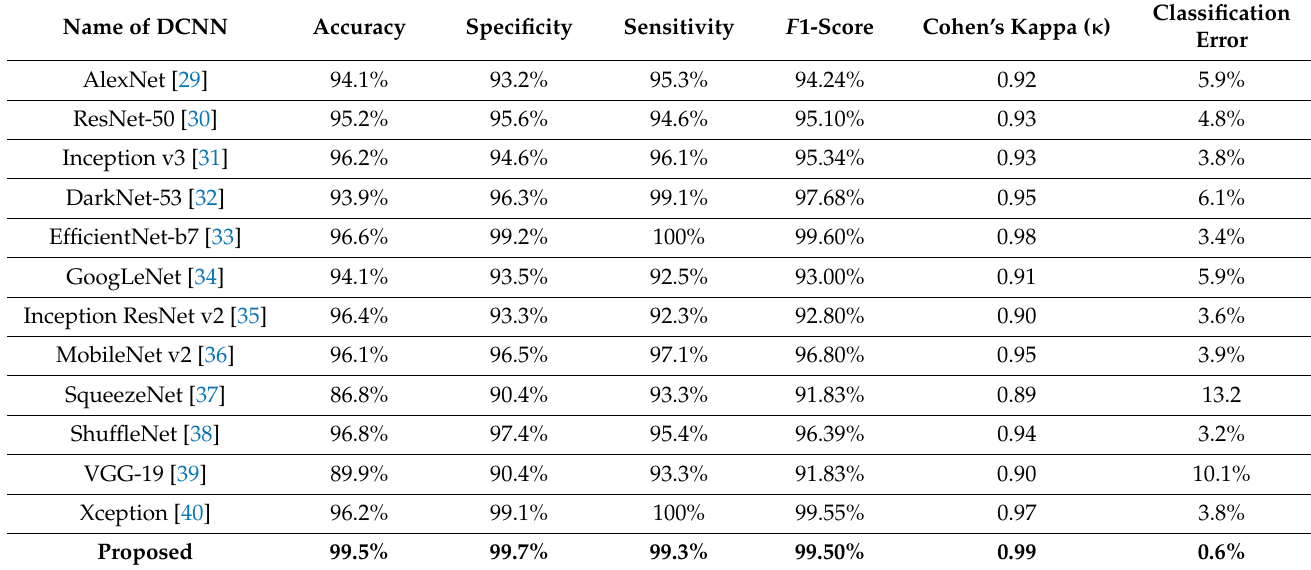
Table 3. Testing performance of different DCNNs for the CT scan